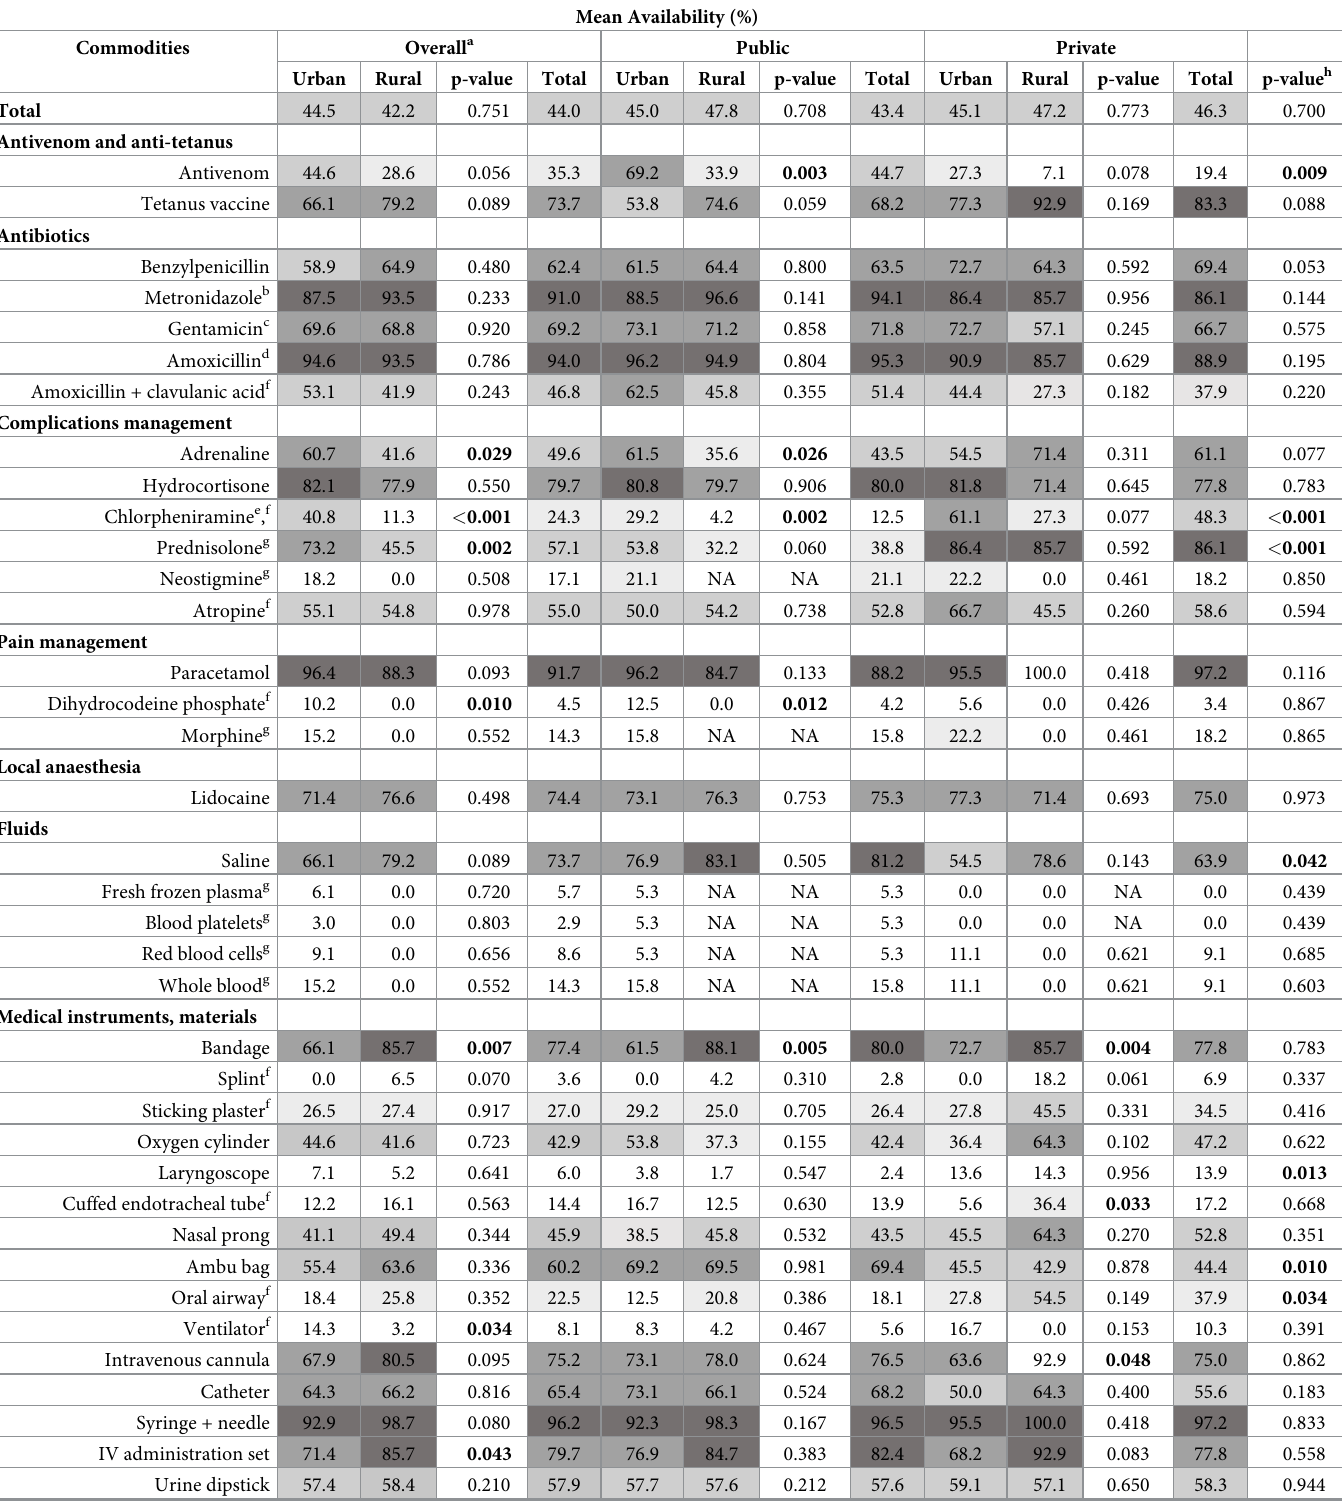
Table 2. Availability of snakebite commodities in Kenya, per sector and location.